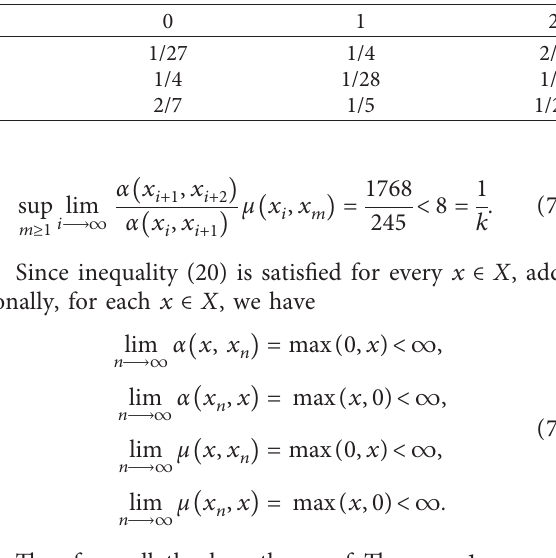
Table 2: Metric d defined in Example